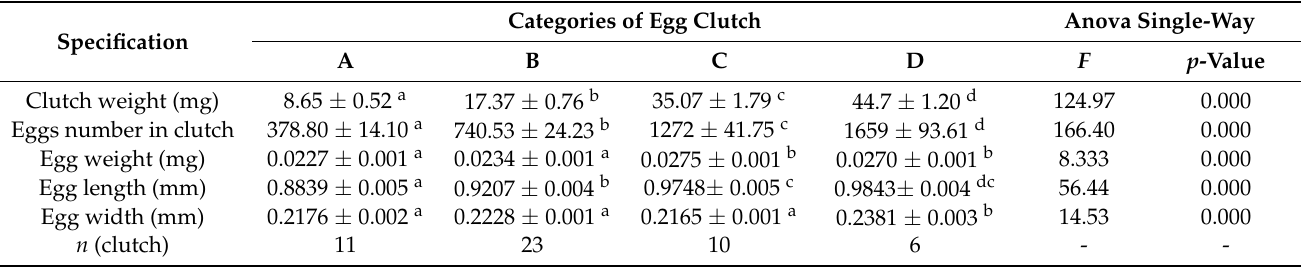
Table 1. Quality parameters of different sizes of Hermetia illucens egg clutch (mean ±